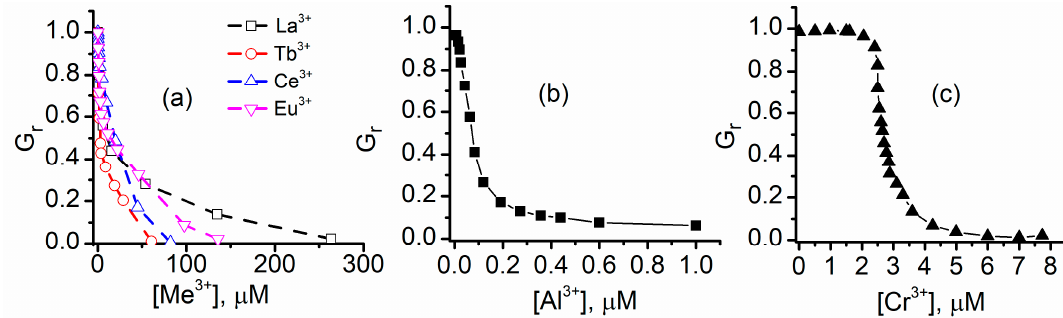
Figure 3. Modulation of the macroscopic conductance of lysenin channels by trivalent metal ions. ( a ) Lanthanide addition completely suppresses the macroscopic conductance in a concentration- dependent manner; ( b ) Al 3+ ions are strong inhibitors and reduce the conductance to negligible values in the µM range; ( c ) Cr 3+ , a potent conductance inhibitor, presents an inhibition curve that suggests a cooperative process. Adapted from [62] (panel a ) and [61] (panels b , c ), with